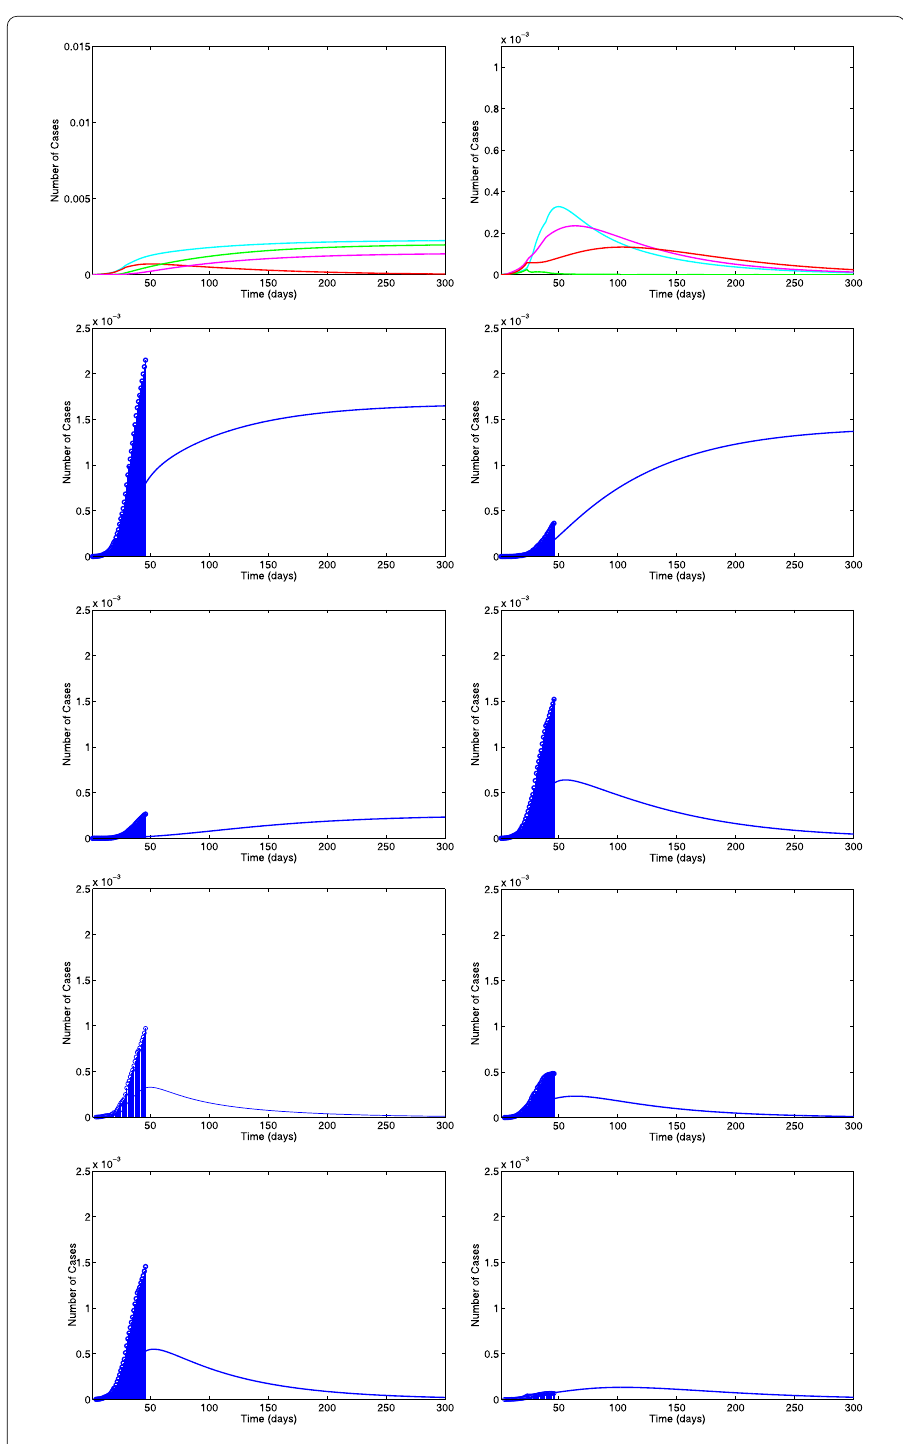
Figure 3 The epidemic numerical simulations of (2) from real-life